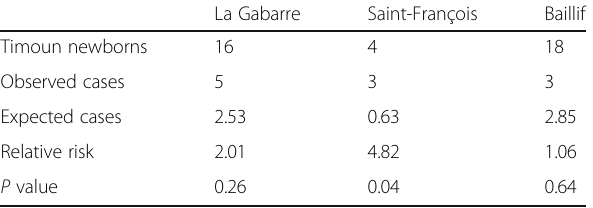
Table 3 Clusters of preterm births in the vicinity of open landfills (Timoun cohort, Guadeloupe archipelago, 2004 – 2007, 2-km